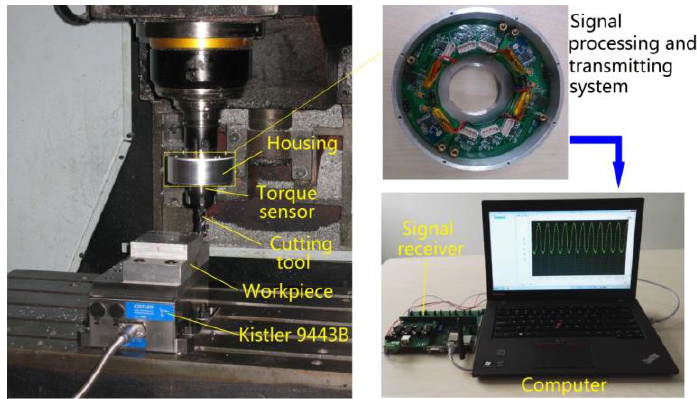
Figure 11. Dynamic cutting experiment.